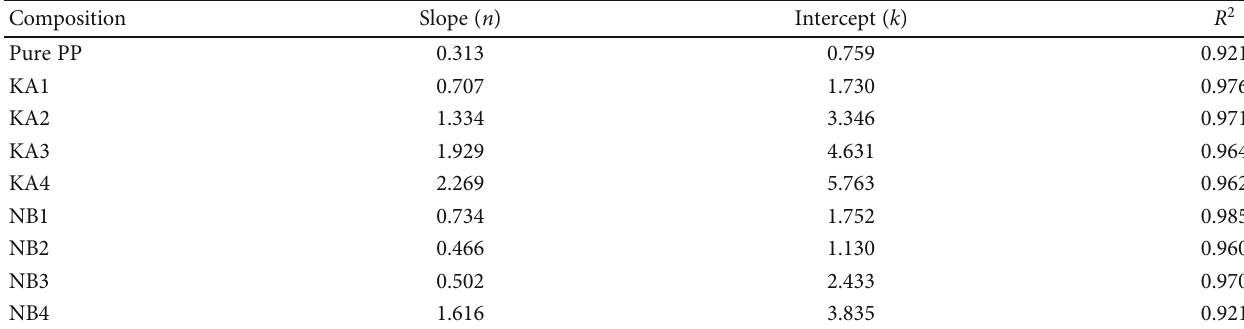
Figure 12: Di ff usion mechanism curve for NaOH-treated composites and the pure PP. Table 6: Moisture contents values obtained for the composites.